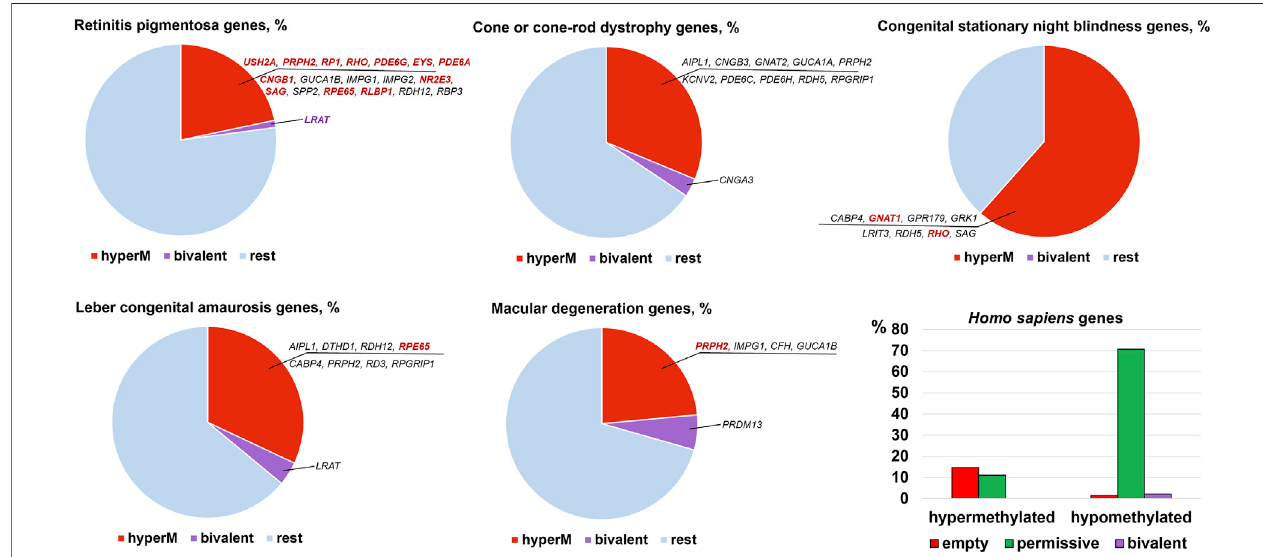
FIGURE 2 | Promoters of many genes associated with retinal inherited diseases are hypermethylated in human embryonic retinas at FW10-FW23, time points at which the majority of cells are RPCs. Meanwhile, the number of genes with bivalent promoters associated with the studied disease was 1 or 0. Many hypermethylated promoters were in an “ empty ” chromatin state. Mutations in the genes colored bright red account for the majority of cases of the respective diseases.